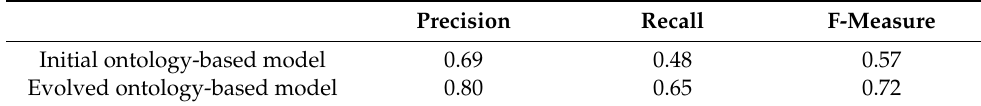
Table 9. Initial and evolved ontology-based models’ coverage